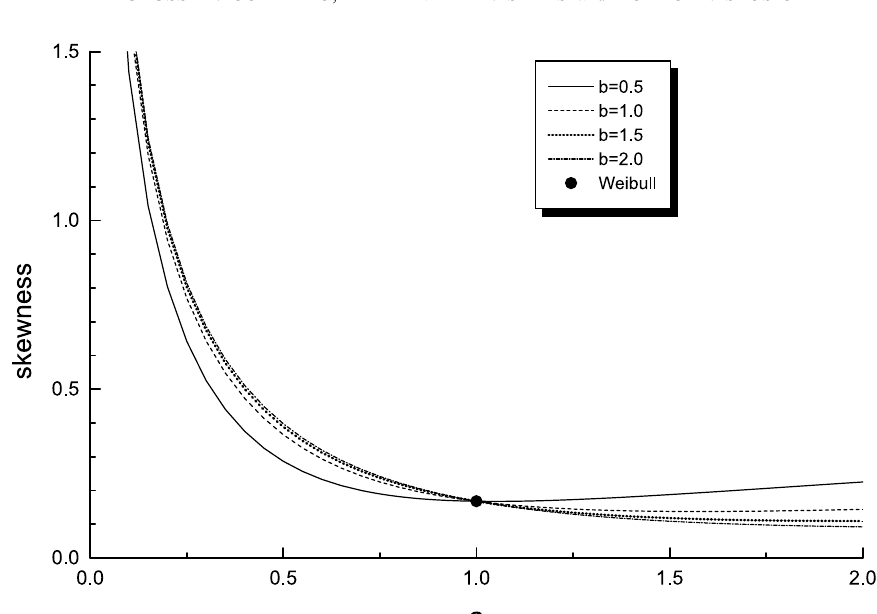
Fig. 3 – Skewness of the BW distribution as a function of parameter a for selected values of parameter b .